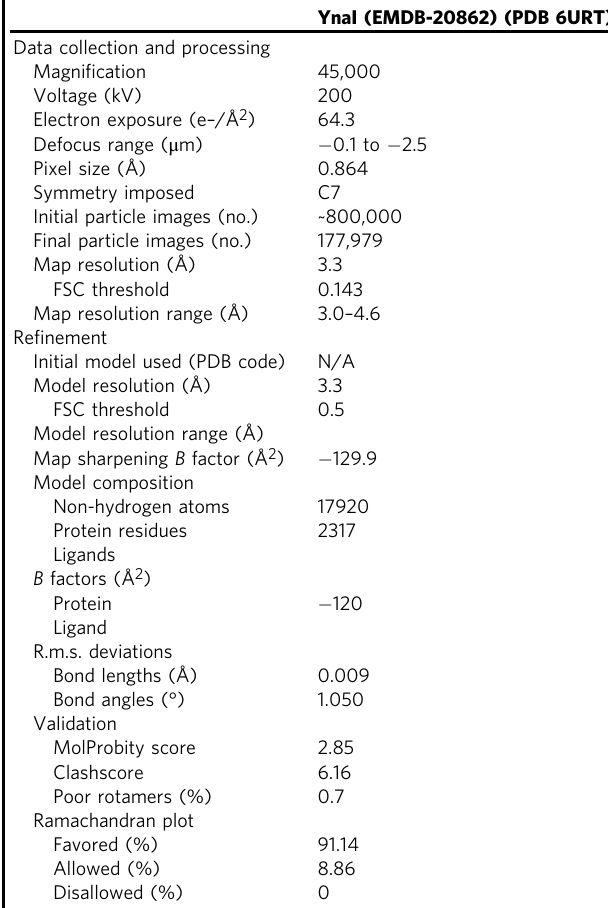
Table 1 Cryo-EM data collection, re fi nement, and validation